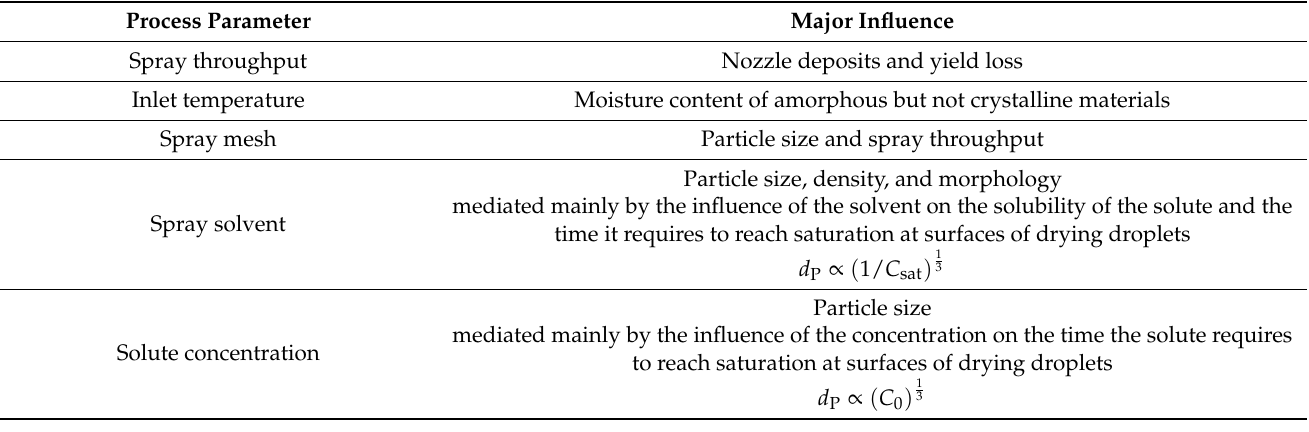
Table 4. The process parameters of the Büchi Nano Spray Dryer B-90 and their major influences on the spray dryer performance and product